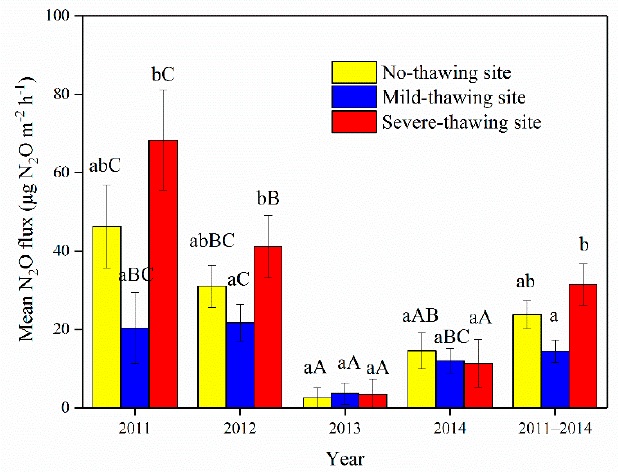
Figure 8. Mean N 2 O fluxes in different years and sampling sites. Data are means ± SE. n = 18 in 2011, n = 16 in 2012, n = 17 in 2013 and 2014. Different lowercase letters indicate the significant differences among sites in the same year or the mean of the four years. Different capital letters indicate the significant differences in the same site between different years.